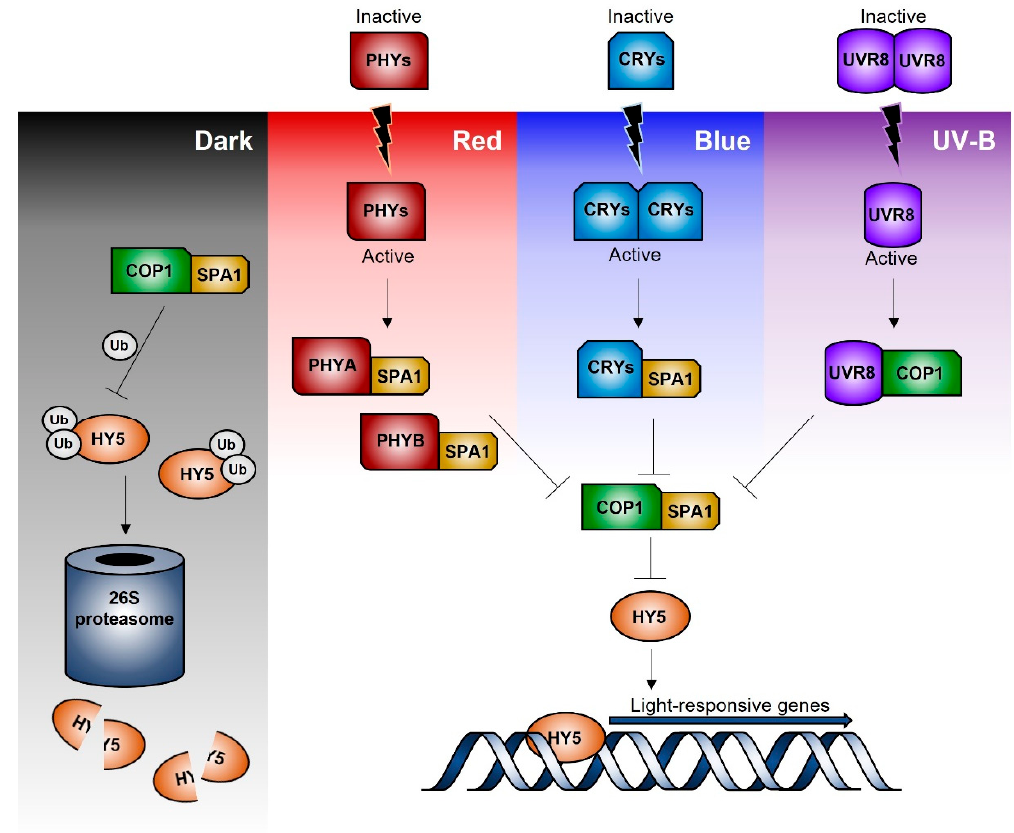
Figure 2. Simplified plant perception mechanisms of different types of solar radiation (dark, red, blue, and UV-B), together with the intracellular rearrangements leading to the transcription of specific light-responsive genes.